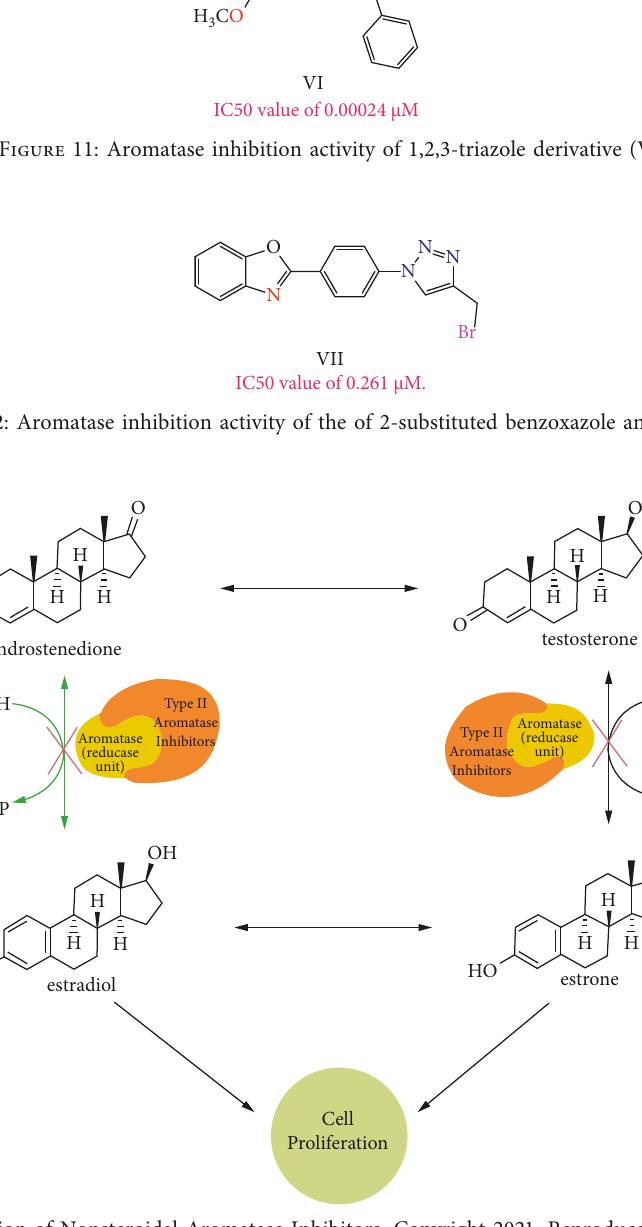
Figure 13: Mechanism of action of Nonsteroidal Aromatase Inhibitors. Copyright 2021. Reproduced with permission from